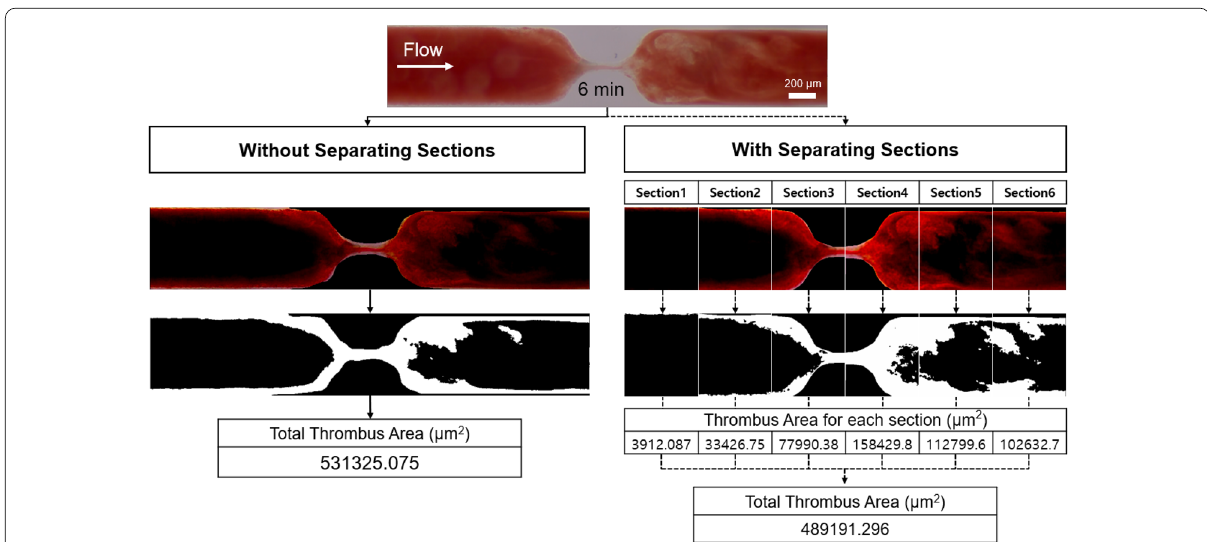
Fig. 7 Method of analyzing thrombus formation when the scope of analysis is wide. If the analysis range is wide, visualizing and calculating the area by dividing the sections can obtain an image similar to the original